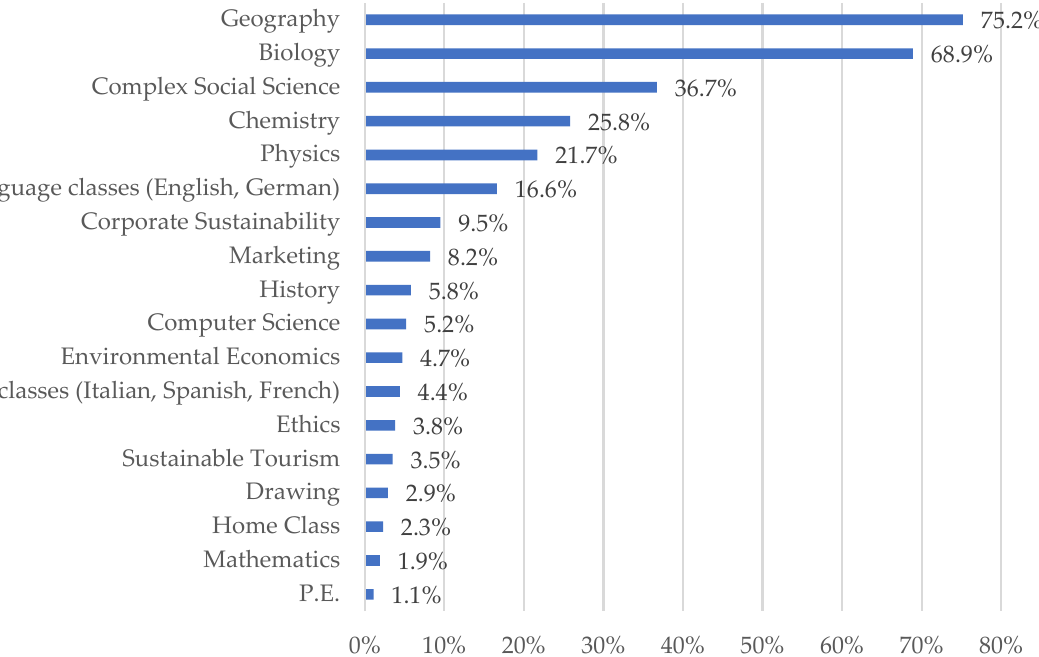
Figure 3. Distribution of students surveyed according to the subjects in which they learned about environmental awareness and renewable energy (%).